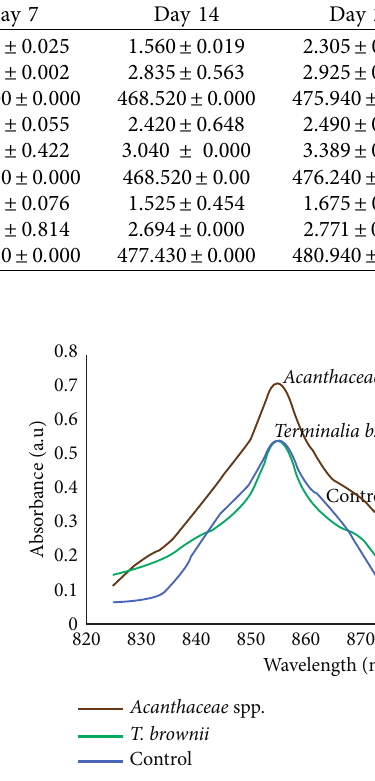
Figure 5: Phosphate levels in bioslurry after retention day